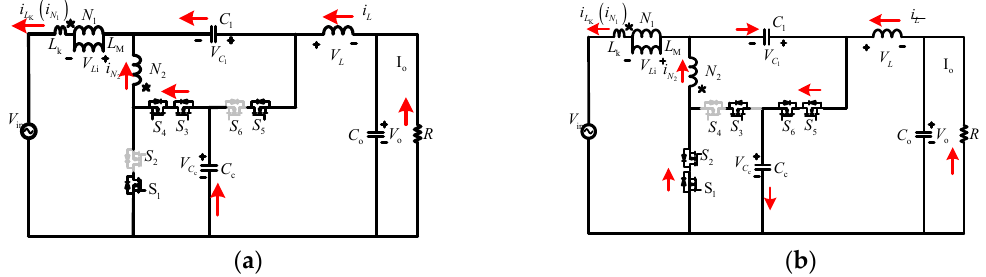
Figure 7. Operation states of the converter when V in < 0: ( a ) Non-shoot through state; ( b ) Shoot through state.